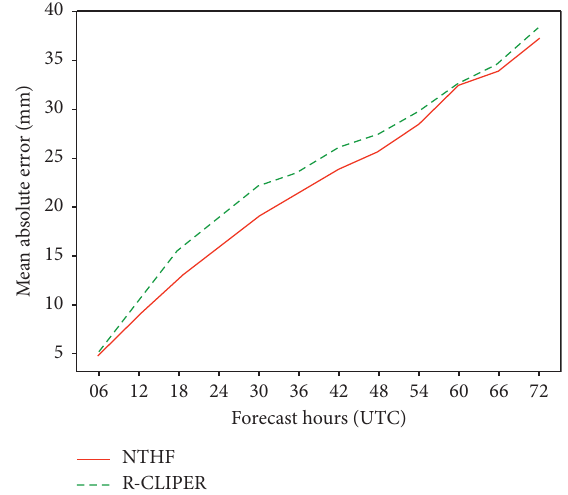
Figure 10: The time evolution of the mean absolute error of both systems. It is possible to note the better performance of NTHF (red line) compared with R-CLIPER (green